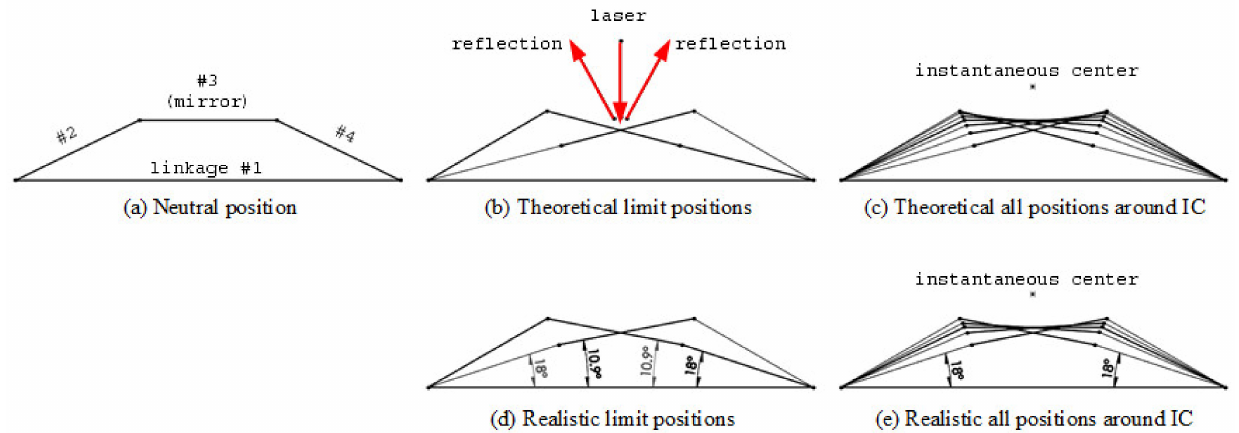
Figure 1. ( a ) Neutral position, ( b ) limit positions, and ( c ) kinematic diagram of the theoretical four-bar mechanism. ( d ) Limit positions and ( d ) kinematic diagram of the realistic four-bar mechanism with 18 ◦ hard stopper to avoid mechanical